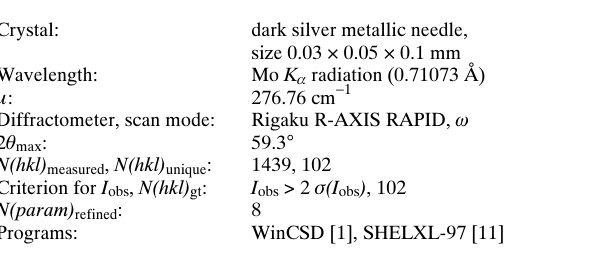
Table 1. Data collection and handling.